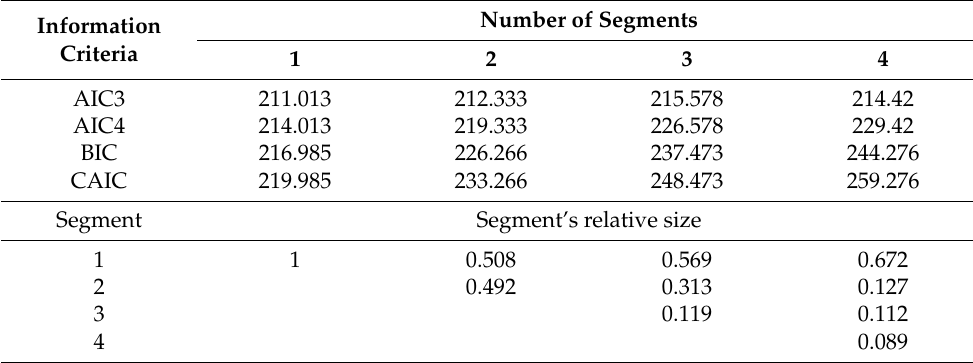
Table 5. Heterogeneity